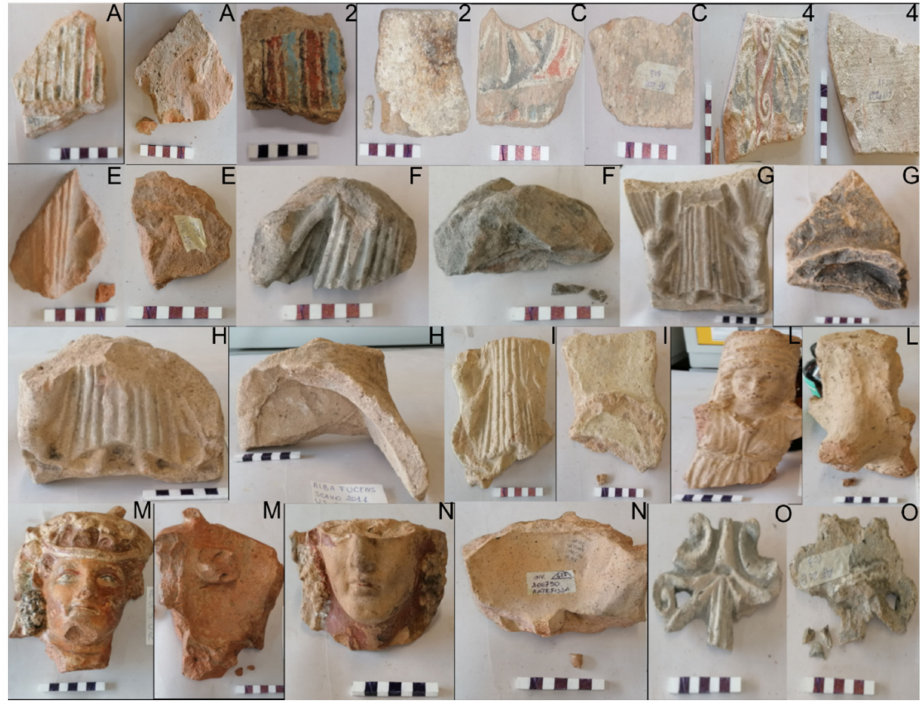
Figure 1. The 13 samples analyzed by XRPD (front and back). Labels ( A – O ) indicate the studied